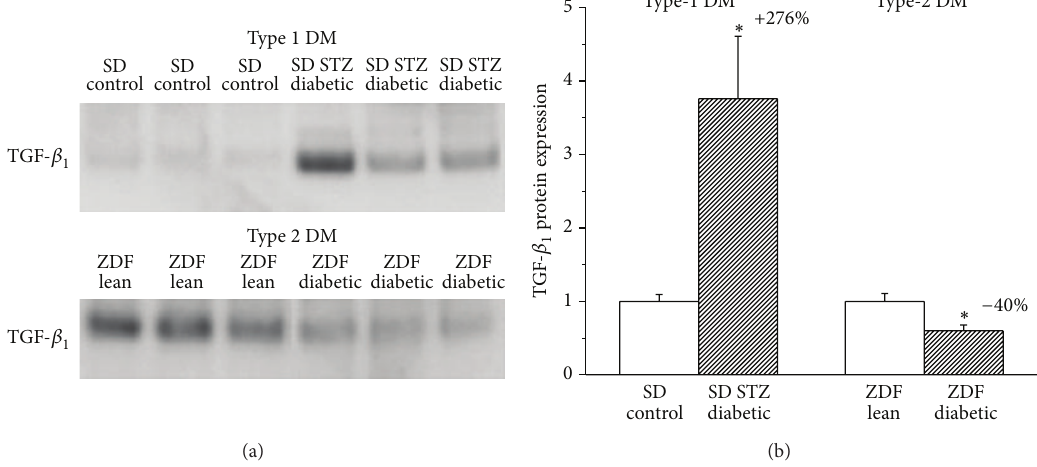
Figure 5: Changes of the myocardial protein expression of transforming growth factor (TGF)- 𝛽 1 in type-1 and type-2 diabetes mellitus (DM) models. Representative immunoblot analysis for the profibrotic mediator transforming growth factor (TGF)- 𝛽 1 from left ventricular myocardium (a) and relative myocardial TGF- 𝛽 1 protein band densities (b) in the groups of SD control, streptozotocin- (STZ-) induced diabetic SD, Zucker Diabetic Fatty (ZDF) lean, and ZDF diabetic rats. Bar graphs represent mean ± SEM. Percent changes between diabetic and corresponding nondiabetic control groups are indicated in both DM models. ∗ : 𝑃 < 0.05 versus the corresponding nondiabetic group.